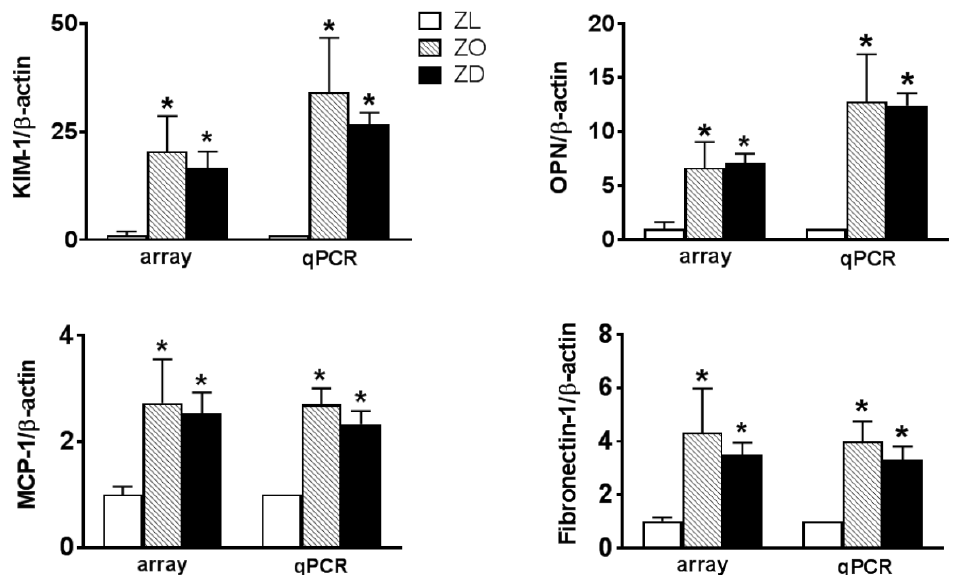
Figure 3. Increased KIM-1, OPN, MCP-1, and fibronectin-1 mRNA levels in ZO and ZD kidneys. mRNA levels of KIM-1, OPN, MCP-1, and fibronectin-1 in the kidney cortex of ZL, ZO, and ZD rats were measured by gene microarray (array) and quantitative real-time PCR (qPCR). mRNA fold changes were calculated using β –actin as an internal control. Values are the mean ± SEM. n = 3–6 animals / group. * p < 0.05 vs. the ZL group.